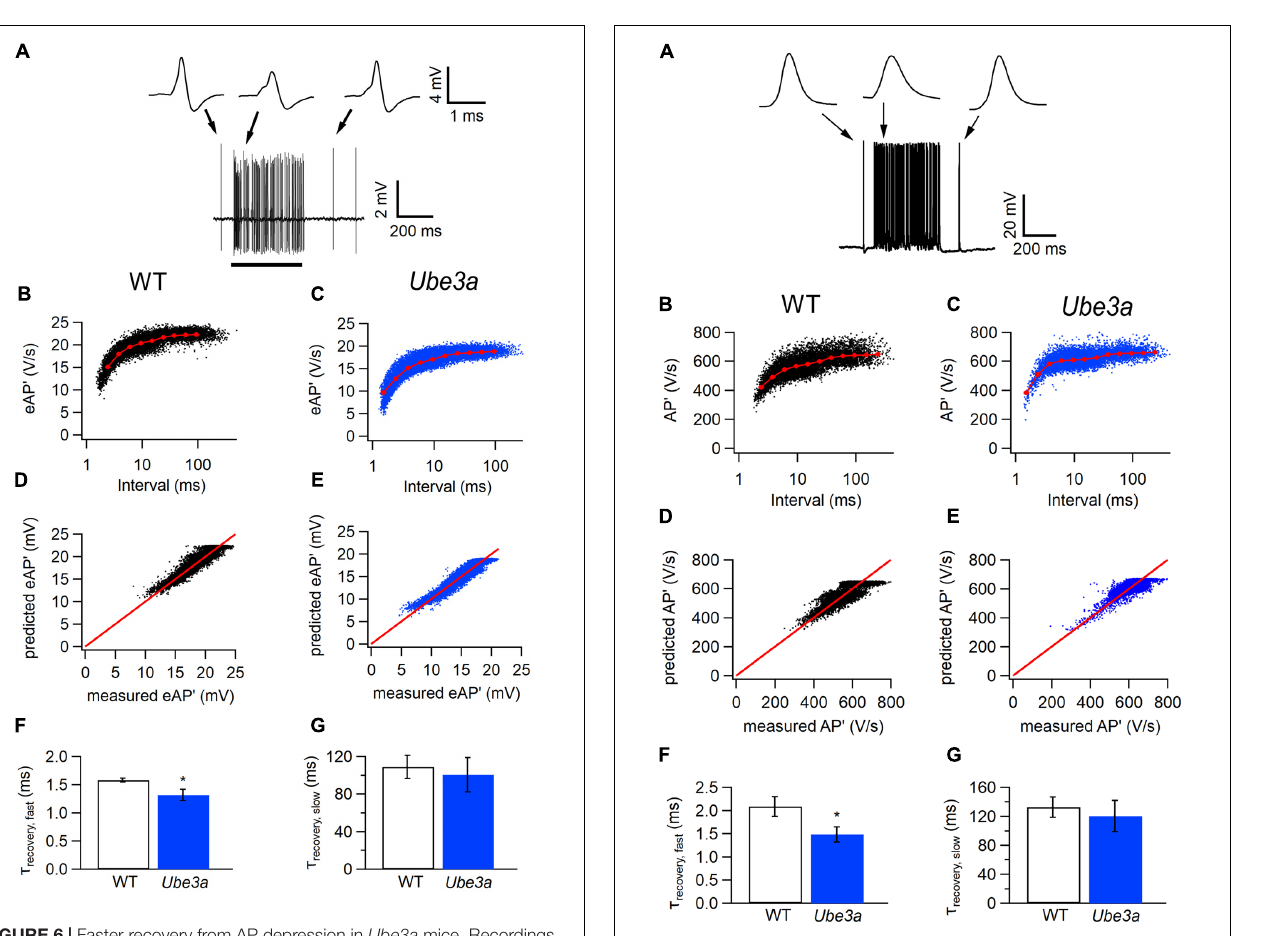
FIGURE 7 | Faster recovery from AP depression in whole-cell configuration in Ube3a mice. (A) Increase in spike frequency during a 400 ms, 80 dB noise burst in a whole-cell recording. Insets are three principal neuron APs before, during and after the sound stimulation, respectively. (B,C) Relation between the maximal amplitudes of the first derivative of the AP (AP’) and the interspike interval from a whole-cell recording (black) from a WT animal (B) and a Ube3a mouse (C) . Red line indicates the binned average of the values predicted by the resource depletion model. (D,E) Relation between AP’ predicted by the model and measured in the whole-cell recording for the data shown in B and C , respectively. (F) Comparison of the fast recovery time constant from eAP depression between WT and Ube3a mice. ∗ Indicates p < 0.05. (G) Comparison of the slow recovery time constant from eAP depression between WT and Ube3a